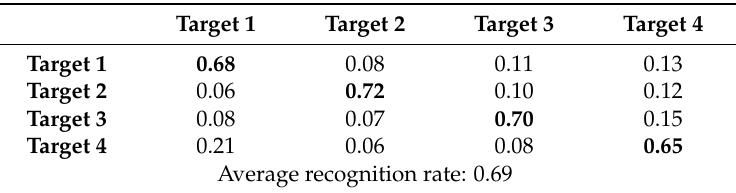
Table 9. Real data recognition result for the HSM-OMP